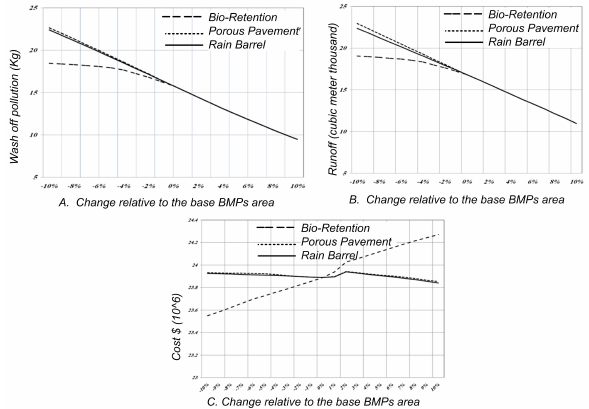
Fig. 6. BMP efficiencies: (A) in terms of runoff quantity control, (B) in terms of runoff quality control, and (C) on the damage